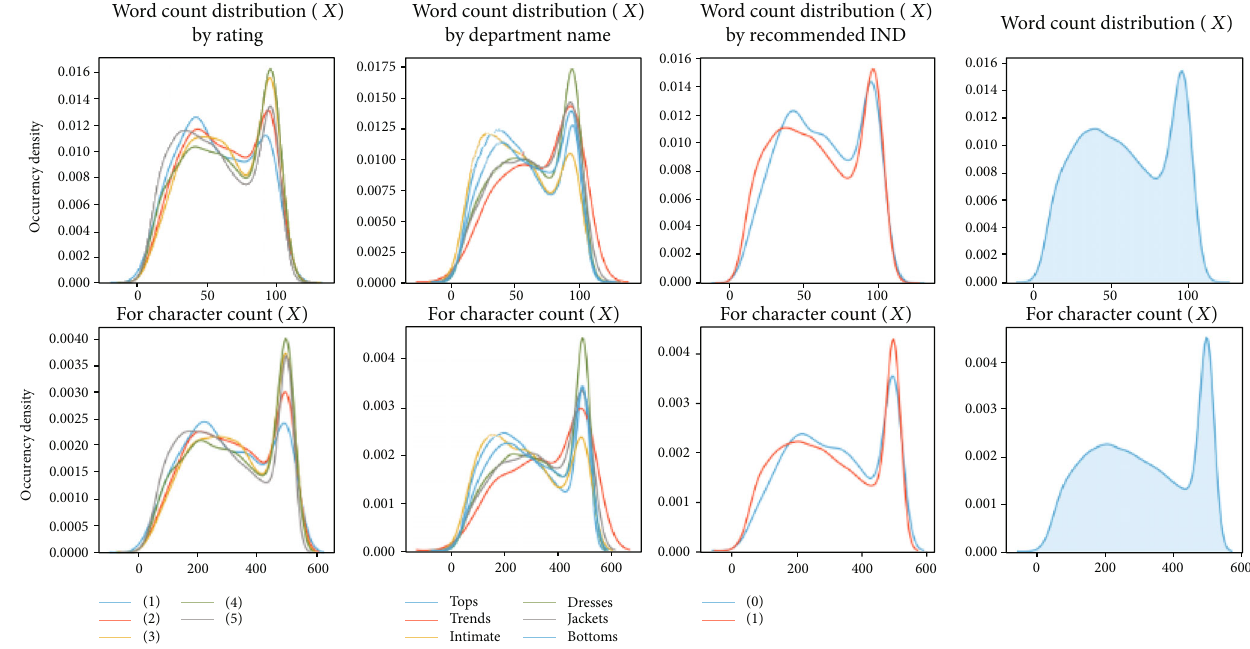
Figure 6: The distribution of count length and characters of the word. Table 5: Character count of review vs. word counts of the women ’ s clothing dataset.